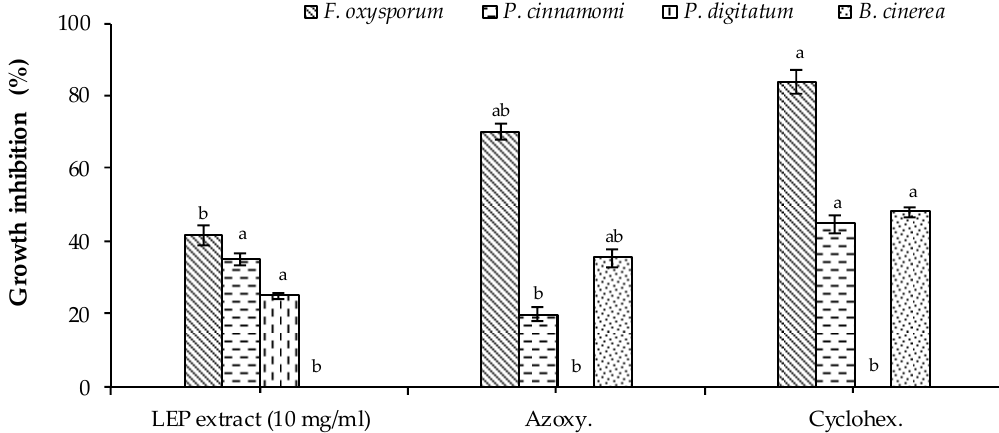
Figure 2. Antifungal activity of the LEP extract. Bars with different letters indicate mean values significantly different at p < 0.05, according to a one-way ANOVA combined with Tukey’s post-hoc test. Data are expressed as the mean of three replicates ± SD.